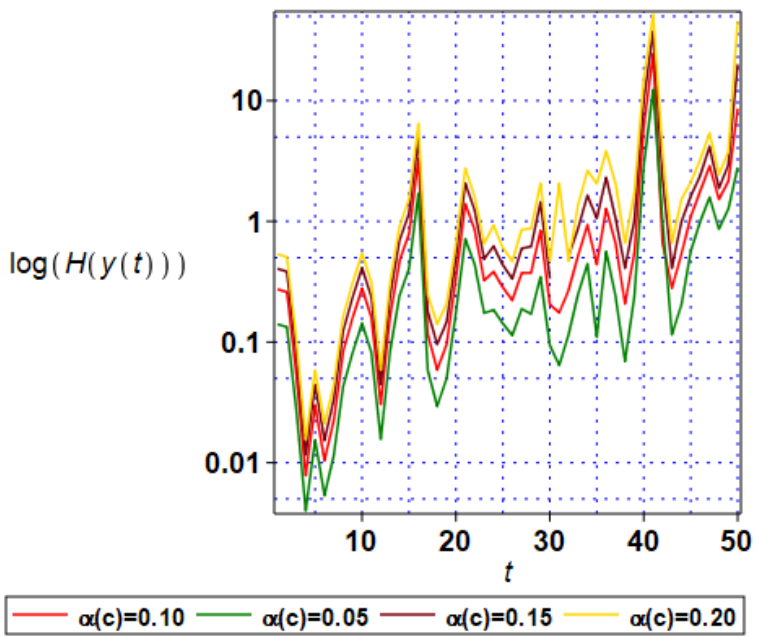
Figure 6. Shannon entropies logarithm time fluctuations for Gaussian structural damping.